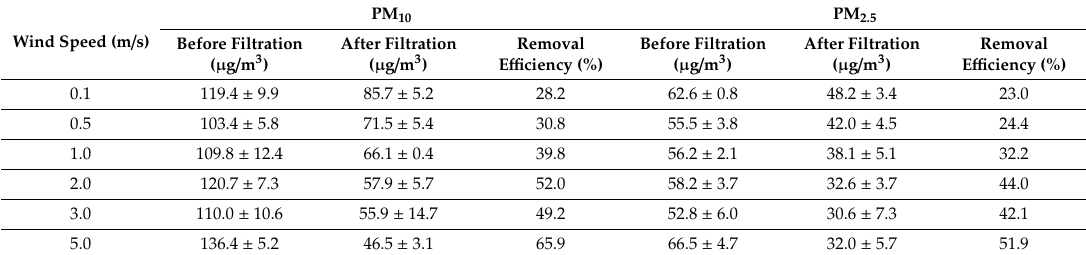
Table 4. Average fine PM removal e ffi ciency of the ACF filter for di ff erent wind speeds at an ACF depth of 600 mm.